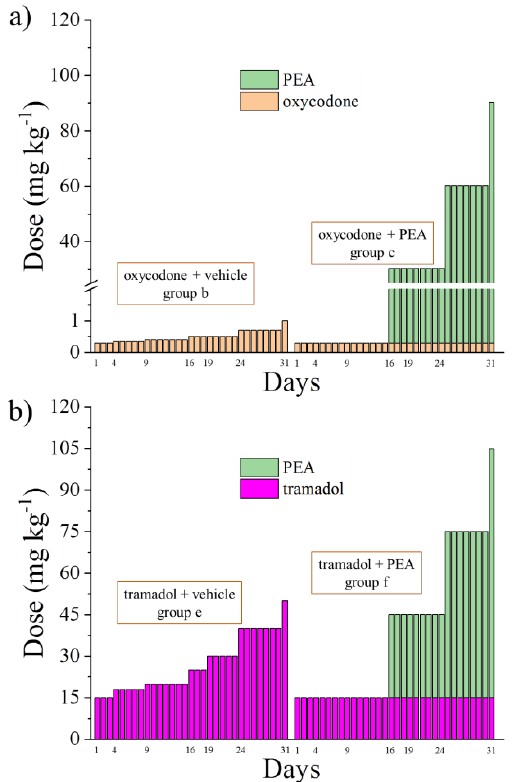
Figure 7. Comparison among equally analgesic dosages of oxycodone–PEA or tramadol–PEA combinations, and oxycodone or tramadol alone. Animals were treated with the vehicle or pre-emptive PEA (30 mg kg − 1 ) p.o. daily (in the evening) for the duration of the experiment, starting on Day − 8. To maintain a significant daily increase in the pain threshold (90 ± 10 g) vs. the baseline, from Day 1 to Day 31, increasing doses of ( a ) oxycodone (0.3–1 mg kg − 1 ) or ( b ) tramadol (15–50 mg kg − 1 ) were injected s.c. Different combinations of ( a ) oxycodone (0.3–1 mg kg − 1 ) or ( b ) tramadol (15–50 mg kg − 1 ) and PEA (30–90 mg kg − 1 , p.o.) were administered to Groups c and f, respectively. The dosages (in mg kg − 1 ) necessary every day to maintain the required antinociceptive effect evaluated by the paw pressure test (Days 1–31) are reported. Measurements were performed in the morning, 30 min after opioids or/and acute PEA administration. Each group consisted of 12 rats analysed in two different experimental